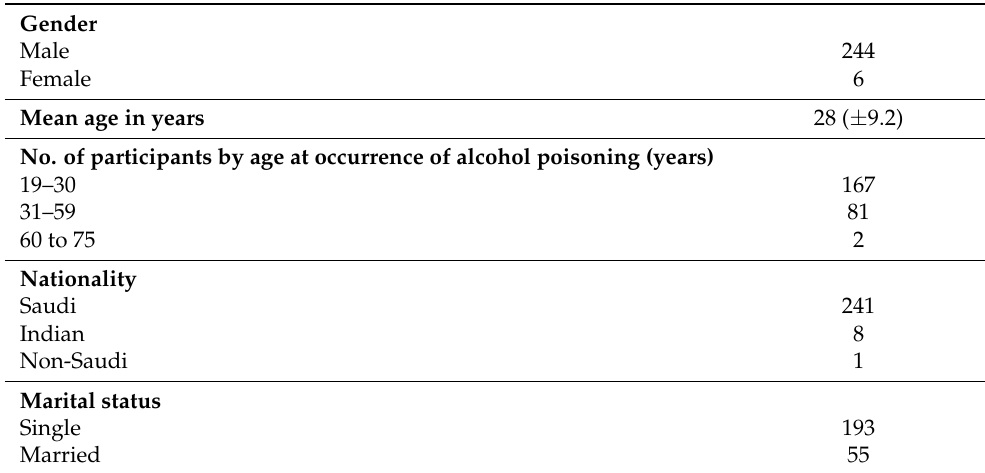
Table 1. Demographic profile of Group